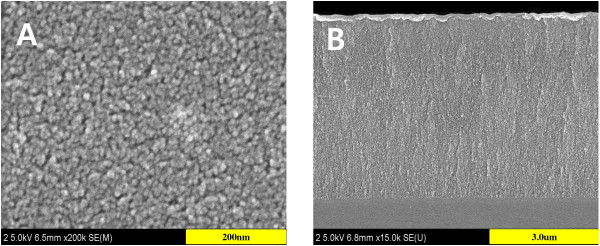
Surface (A) and cross-sectional (B) SEM images of photoluminescent PSi.